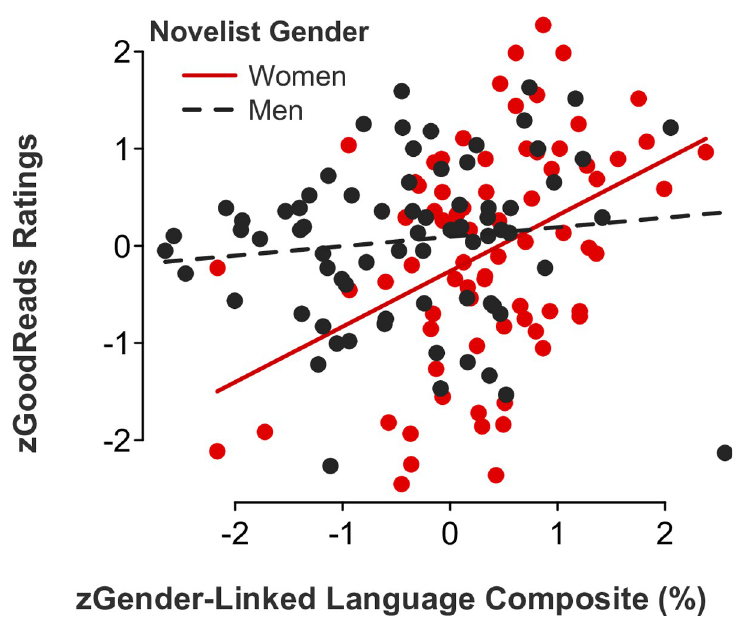
Fig 6. Novel ratings as a function of the gender-linked language composite and novelist